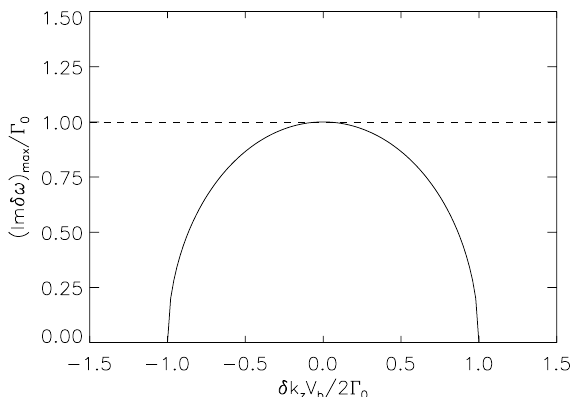
FIG. 5. Plot of normalized growth rate (cid:115) Im dv (cid:100)(cid:121) G (cid:48) versus normalized axial wave number d (cid:107) (cid:122) (cid:86) (cid:98) (cid:121) (cid:50) G (cid:48) calculated from Eq. (95).